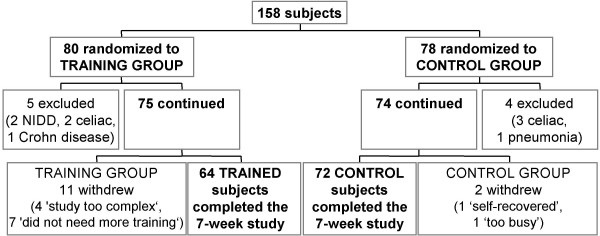
Consort flow chart. Randomization of the subjects recruited for this study into trained and control (untrained) groups. The subjects were men and women, 18 to 60 years of age, with recurrent functional disorders of diarrhea, abdominal pain, or dyspepsia.